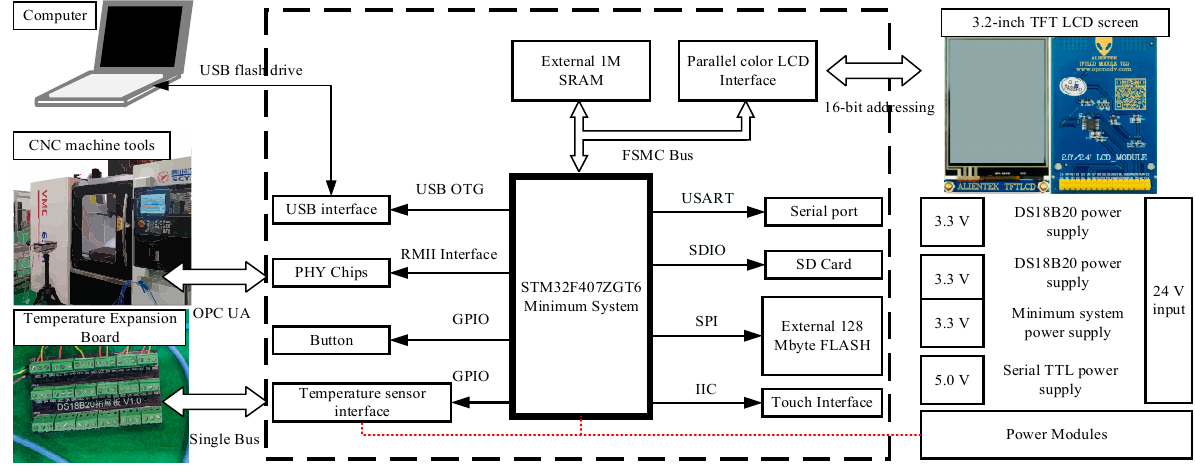
Figure 5. Block diagram of the thermal error compensator hardware circuit.